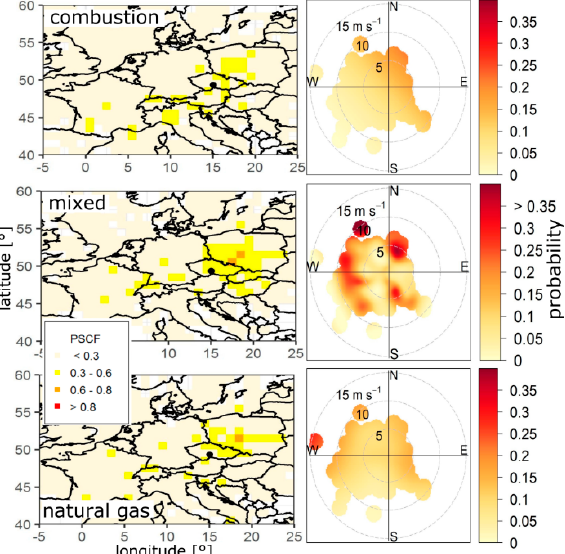
Figure 7. Sources of PMF factors in the cold period of the year, determined using the PSCF method on the left and CBPF method, displayed as probability, on the right.